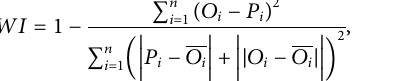
where O i and P i are observed, and the predicted DO value for ith (cid:2) O (cid:2) P observations. and are the mean of observed and the predicted DO, and n is data points. Four statistical metrics and visual inspection using scatter plot, box plot, violin plot, and Taylor diagram were used to assess the performance of the applied models. Different statistical metrics and plots provide different measures of model performance, including error, association, and distribution. Therefore, they were used in this study for a complete assessment of model performance.